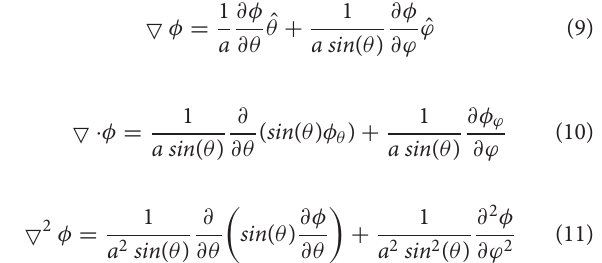
the parameter m ( T ), which controls the deep of the double well m ]. An evolution equation [ 1 f f (0, m ) f (1, m ) 6 = − =